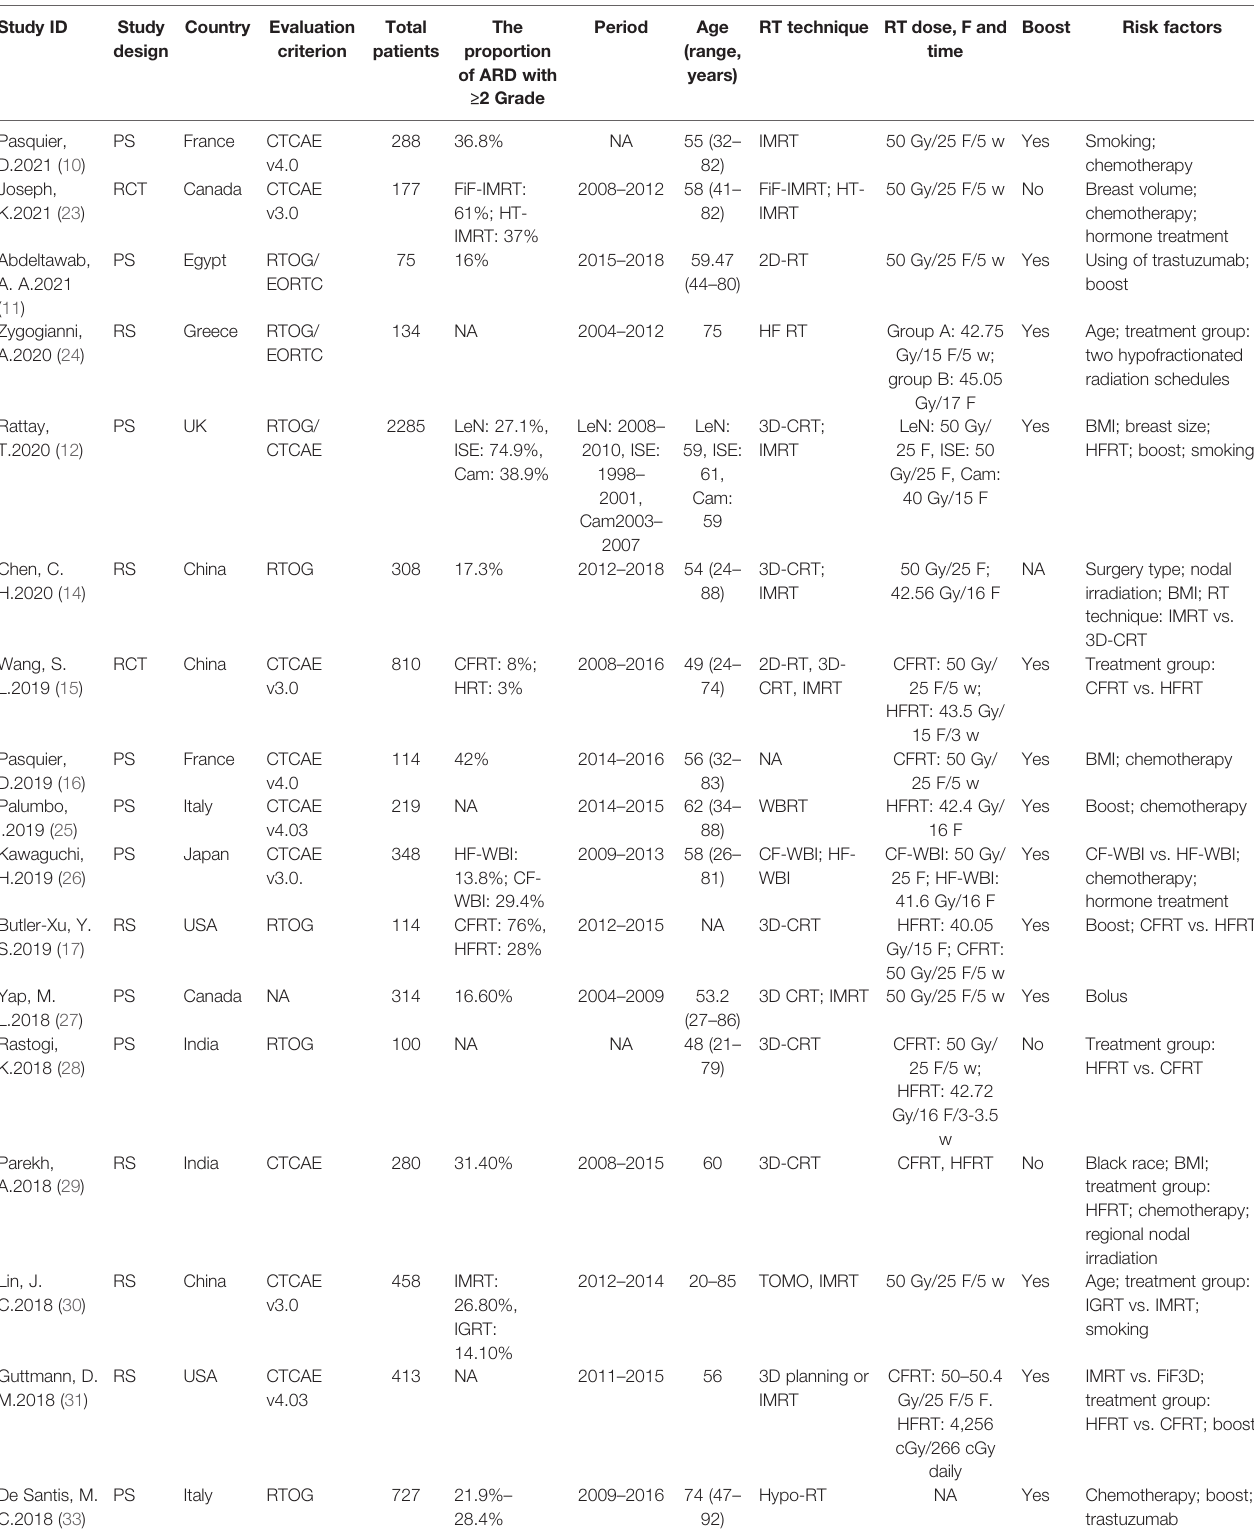
TABLE 1 | The characteristic of included